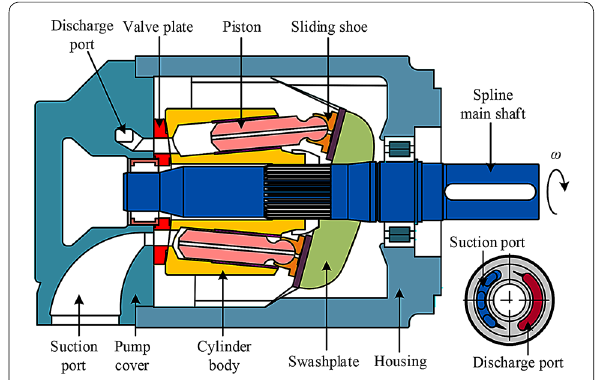
Figure 1 Schematic diagram of axial piston pump with spherical valve plate/cylinder block